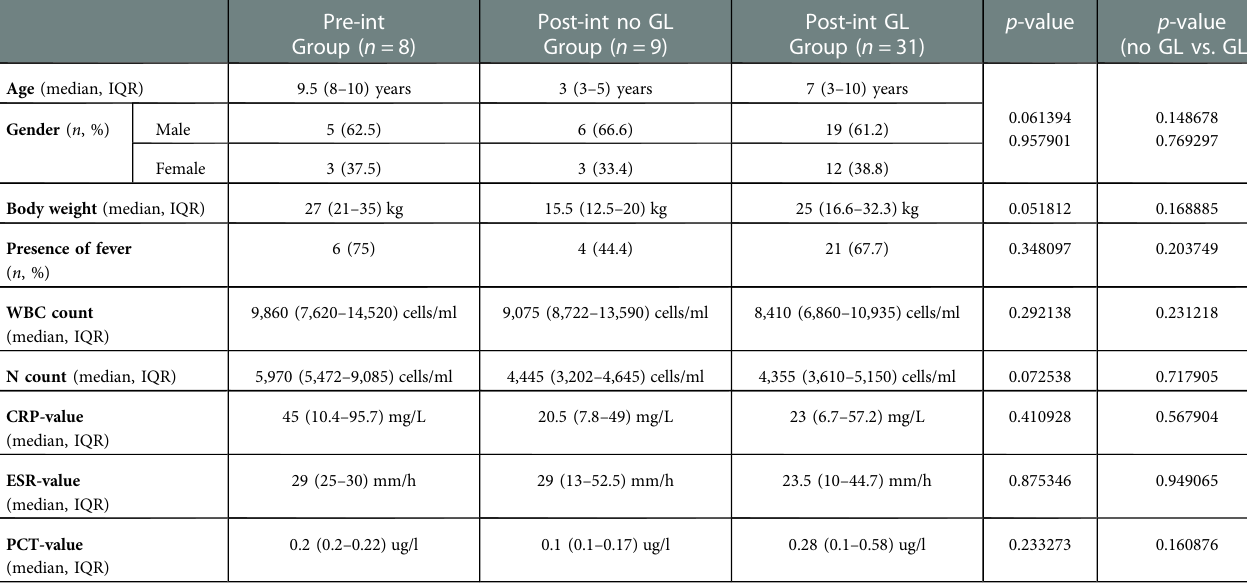
TABLE 1 Characteristics of patients with OM at